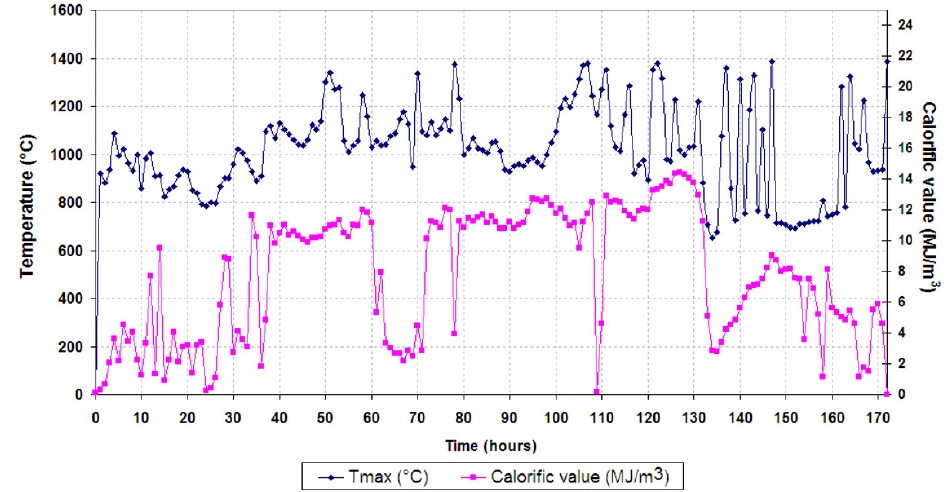
Figure 10. Calorific value and the highest temperature during gasification